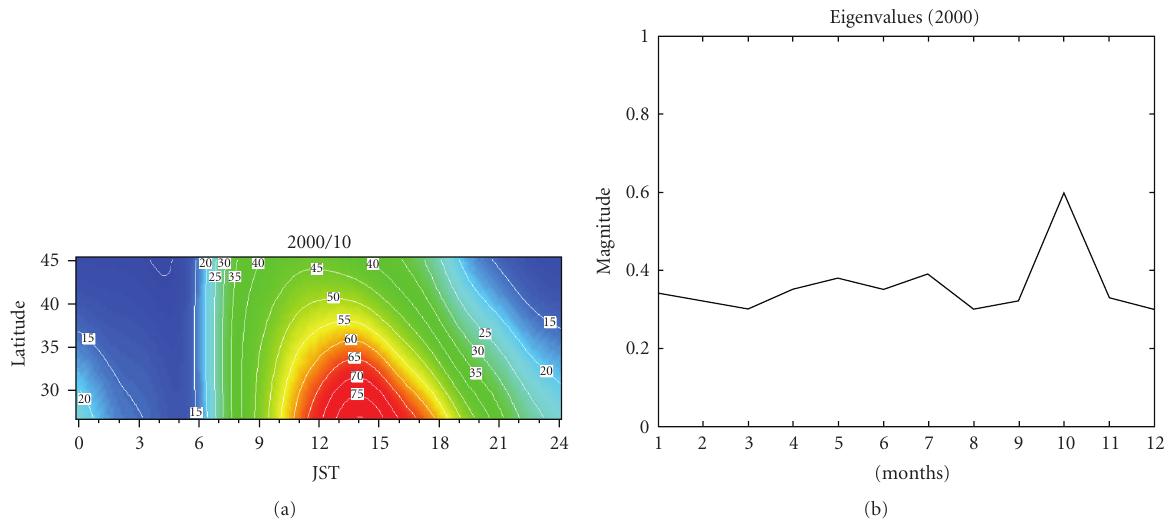
Figure 2: (a) shows the latitude-time TEC record in Japan for October 2000 (JST: Japanese Standard Time) (Unit: TECu). (b) shows 12 principal eigenvalues in 2000. Dates constitute the horizontal axis and corresponding eigenvalues are on the vertical axis. Peaks and troughs in eigenvalues have been plotted and graphed on a month-to-month basis to allow for interpolation. The largest principal eigenvalue is represented in October in which an earthquake occurred on October 6 (Table 1).